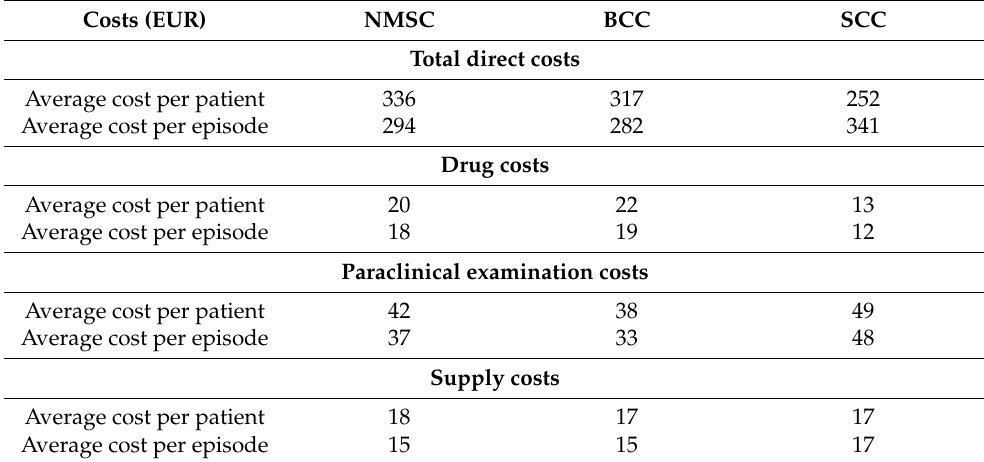
Table 2. Averages of direct cost details of head and neck skin cancers for five years of treatment related to patient and episode of